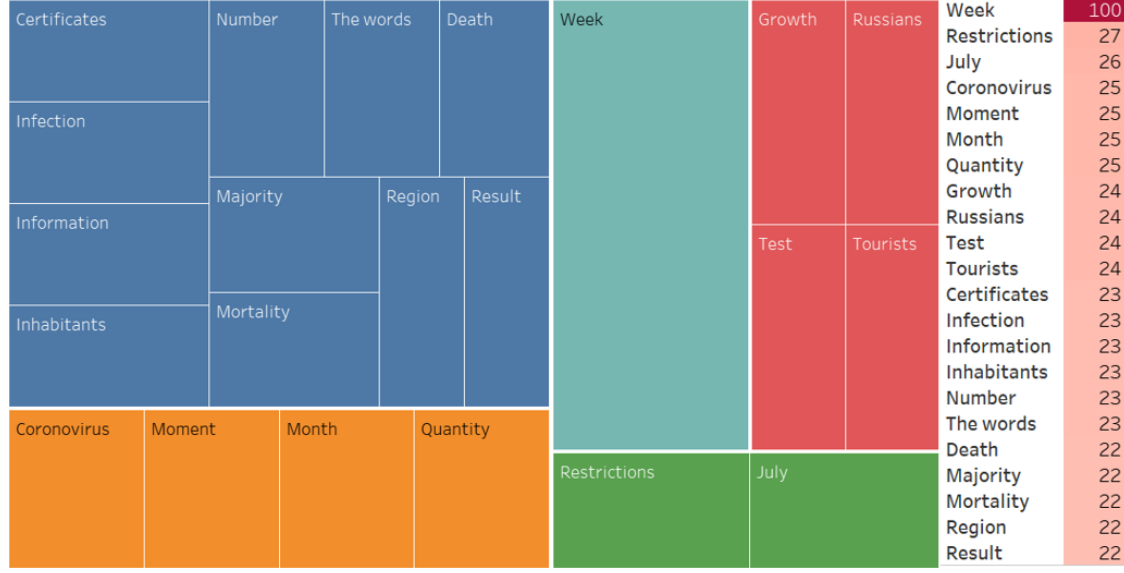
Figure 9. Associative network of the “Non - working days” stimulus in the negative cluster.